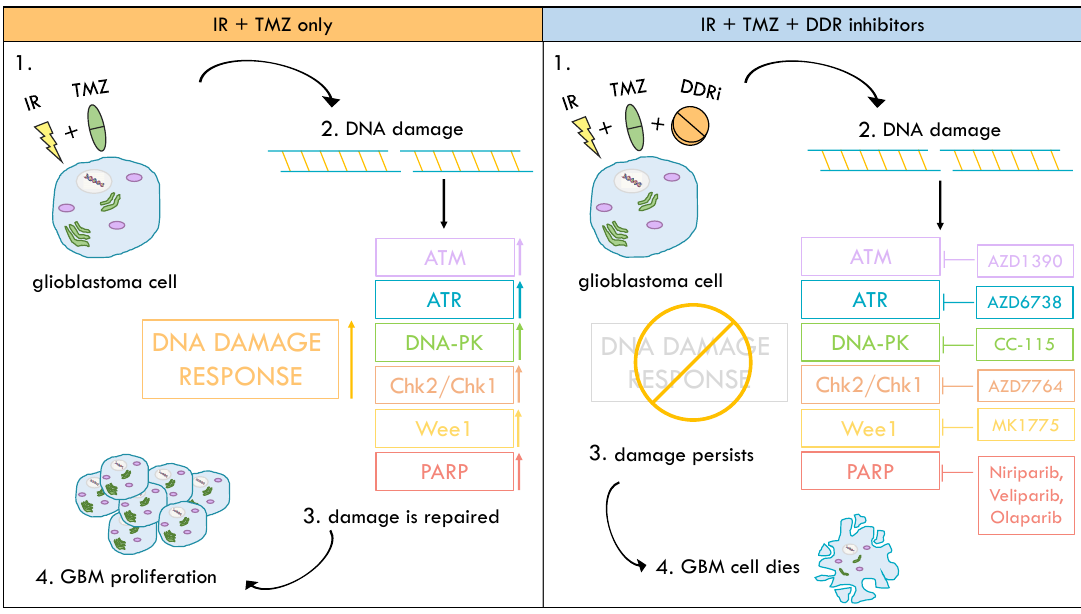
Figure 1. Treatment of cancerous cells with the standard combination of ionizing radiation (IR) and temozolomide (TMZ) causes DNA damage and subsequent activation of the DNA damage response (DDR) kinases (i.e., ATM, ATR and DNA-PK). Over-activation of such proteins is frequent in cancers and is responsible for therapy resistance. Addition of a DDR inhibitor to standard therapy helps reduce DNA repair rate and increases the mortality of tumor cells. Inhibitors shown in the graphic are currently been tested for glioblastoma multiforme (GBM) treatment. IR, ionizing radiation; TMZ,